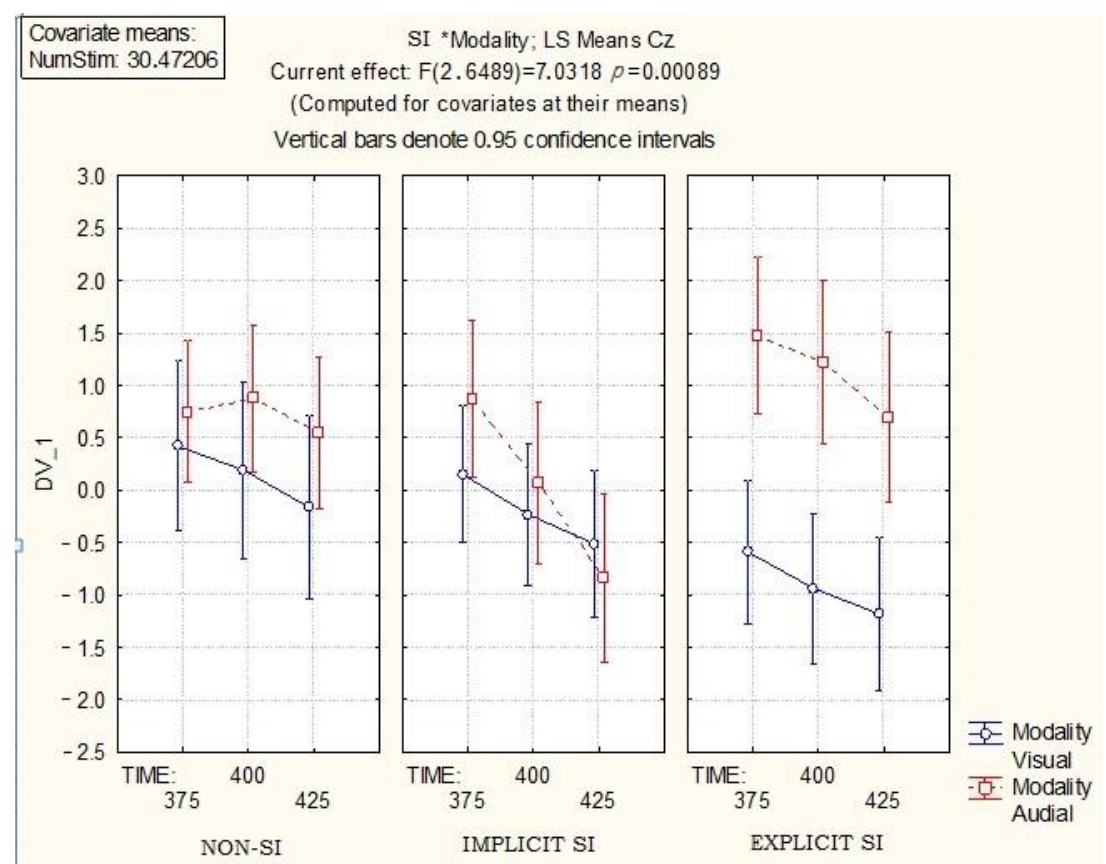
Figure 5. Differences between three groups of stimuli (explicit and implicit SI words and non-SI words) in both modalities (visual and auditory) for Cz channel for time window of 375–425 ms. '*' is a multiplication sign.